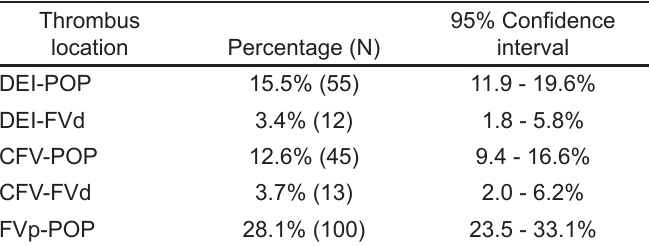
Table 2. Number and rate of lower extremity thrombi spanning multiple regions of the deep leg veins.